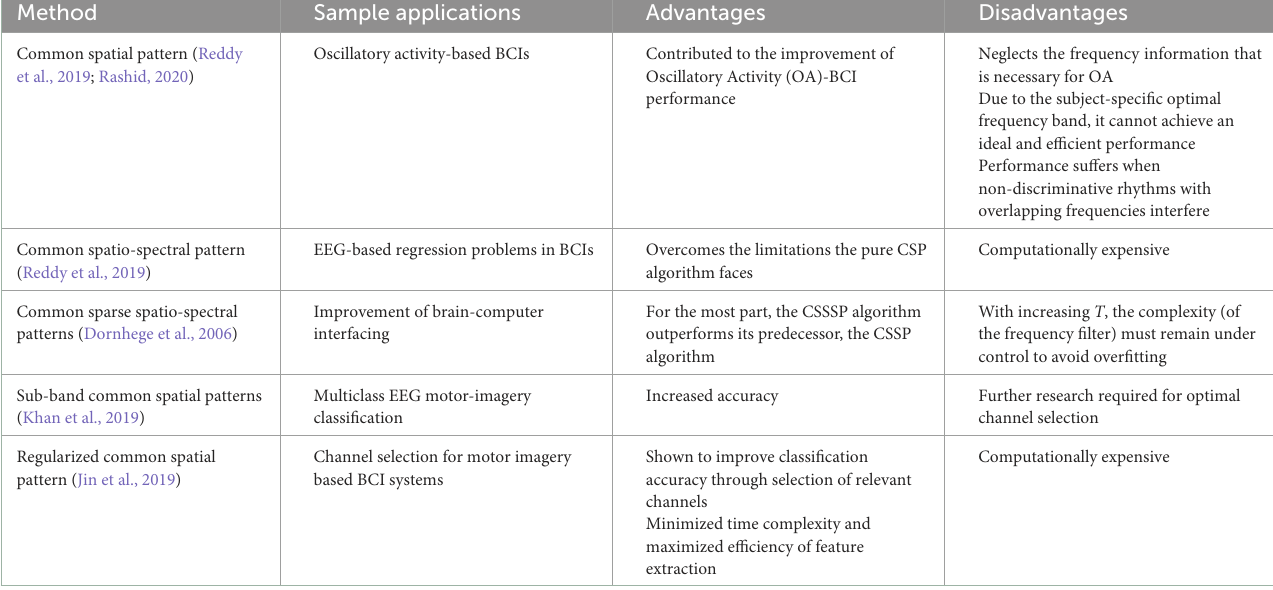
TABLE 5 Summary of spatial-domain feature extraction methods for